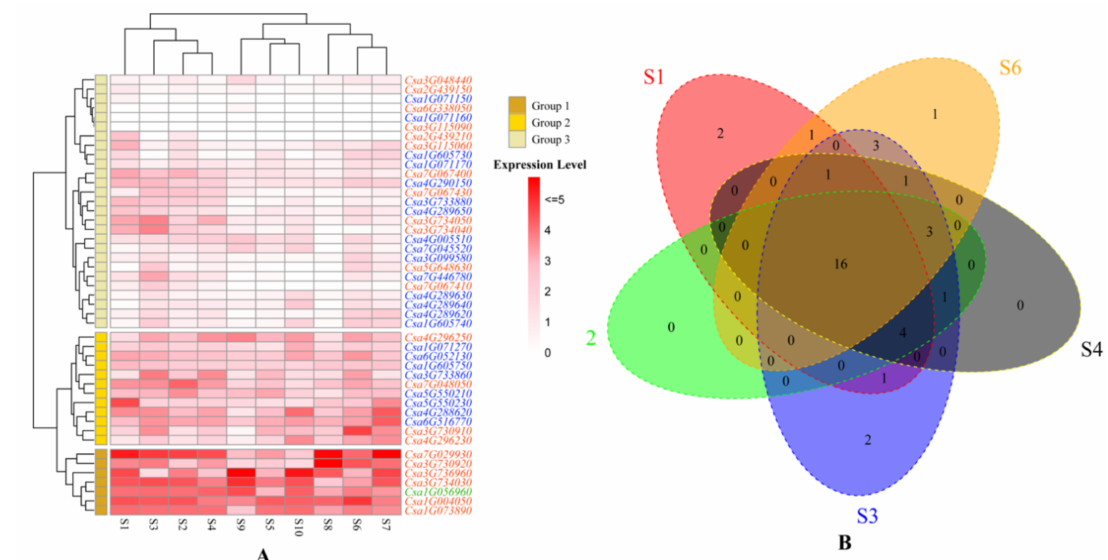
Figure 5. Expression profile of CsLecRLK gene family in di ff erent tissues. ( A ) Heatmap depicting the expression profile of the CsLecRLK family in di ff erent developmental tissues. The red represents L-type CsLecRLK s, the green represents C-type CsLecRLK s and the blue represents G-type CsLecRLK s. Genes highly expressed in tissues are colored red, and genes not expressed in tissues are colored blue; ( B ) Venn diagram depicting the distribution of shared expression of CsLecRLK s in five typical